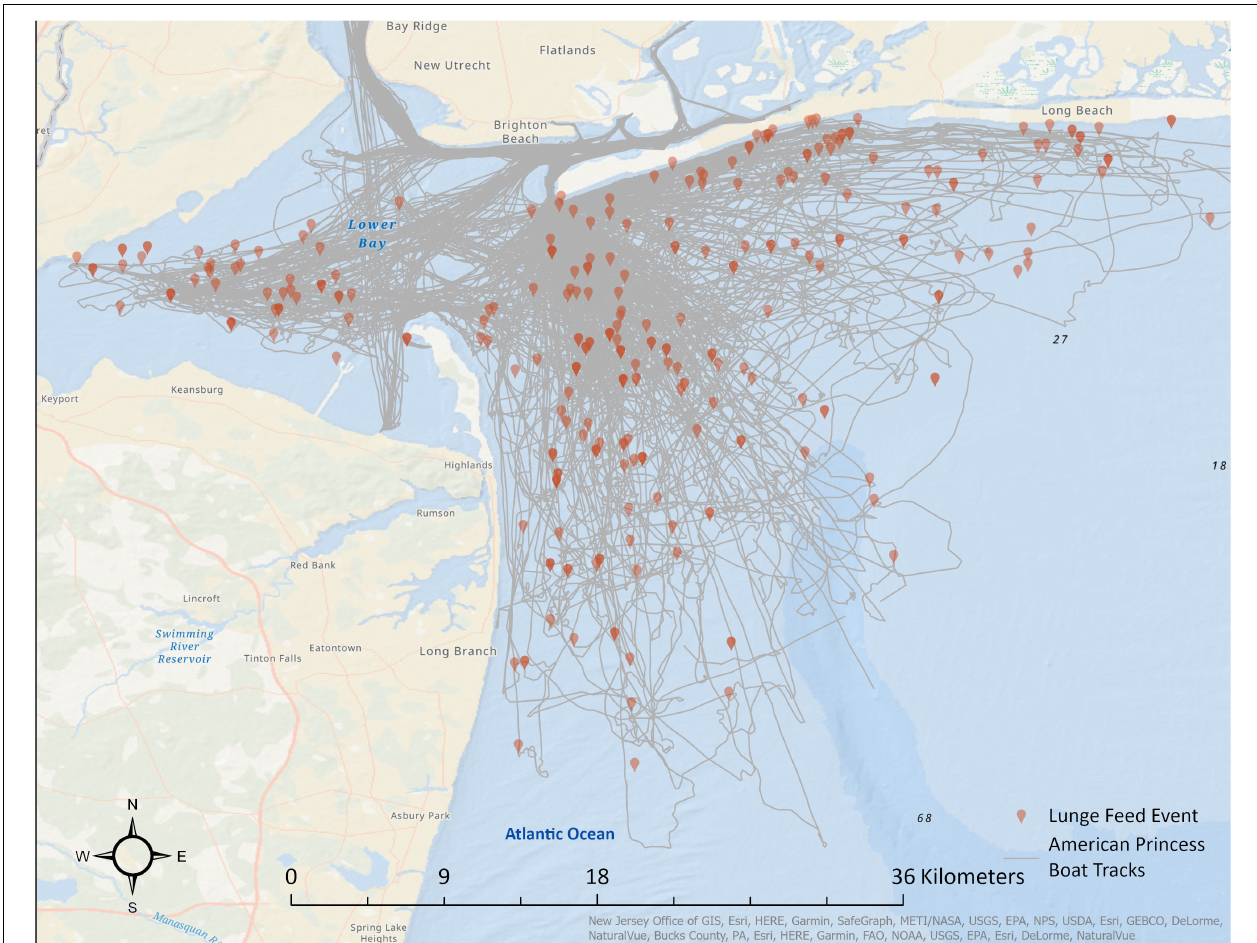
FIGURE 2 | Locations of humpback whale lunge feeding in the study region (2011–2019), placed over the locations of boat tracks in the study region (2016–2019). Sources : Esri, GEBCO, NOAA, National Geographic, DeLorme, HERE, Geonames.org, and other contributors (Esri, 2022a,b).